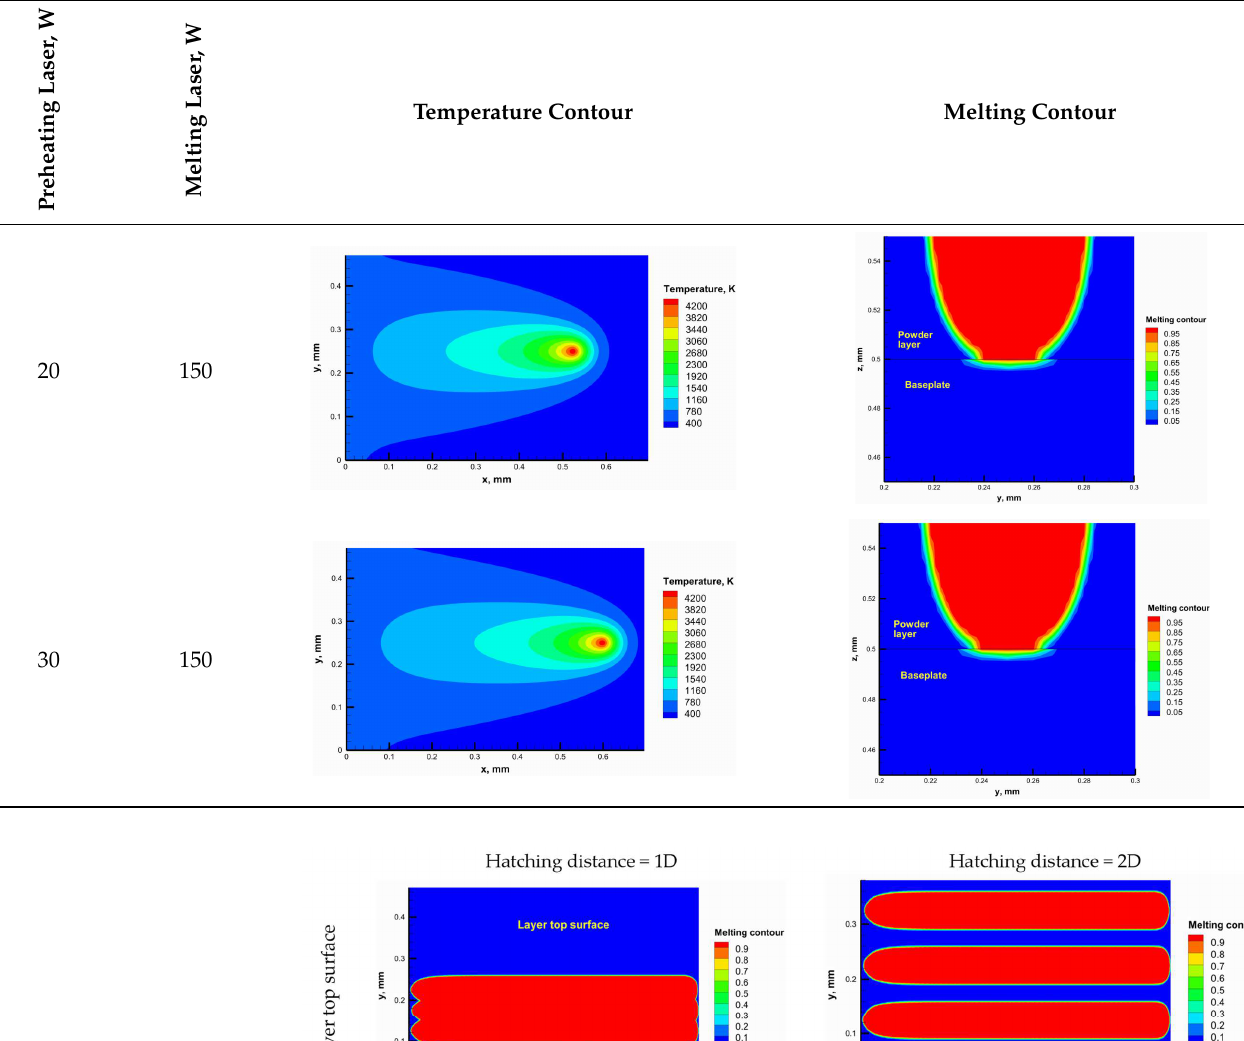
Table 4. Top and cross-section melting contours.